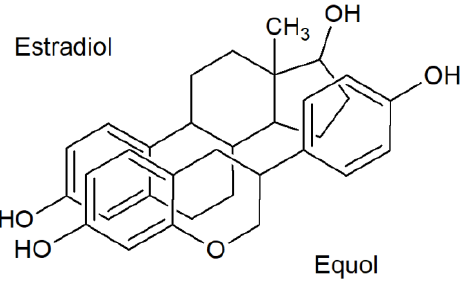
Figure 1. Comparison of estrogen and isoflavone chemical structures [101] Copyright number: 4533100249172 from Oxford University Press.